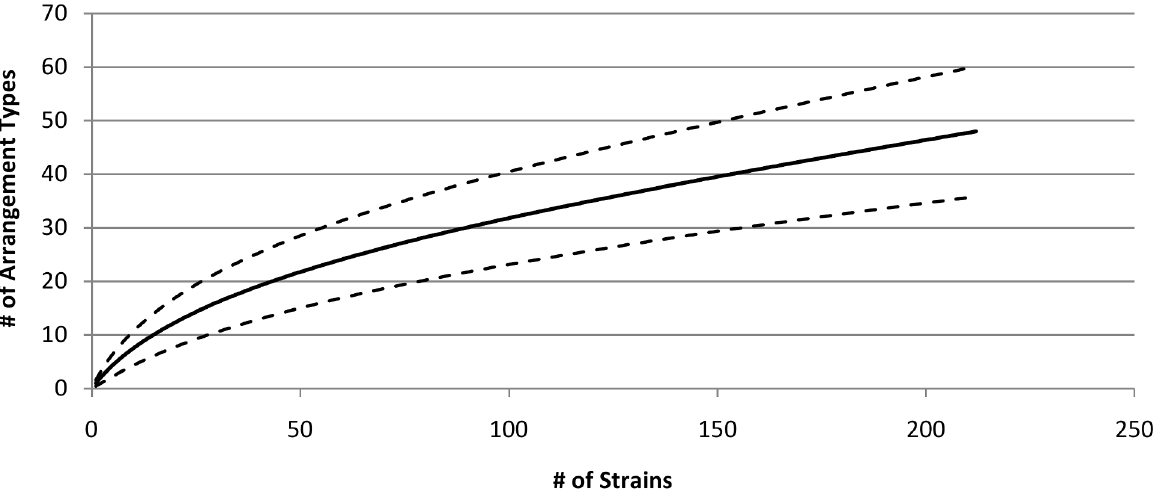
Figure 3. Expected species accumulation curve of naturally-occurring arrangement types. The moment-based estimator of species richness, t ( h ), was computed using EstimateS version 8.2 [55] with 95% confidence intervals (dashed lines). The number of observed arrangement types has not reached a plateau, and will likely increase as more host-specific Salmonella strains are characterized.